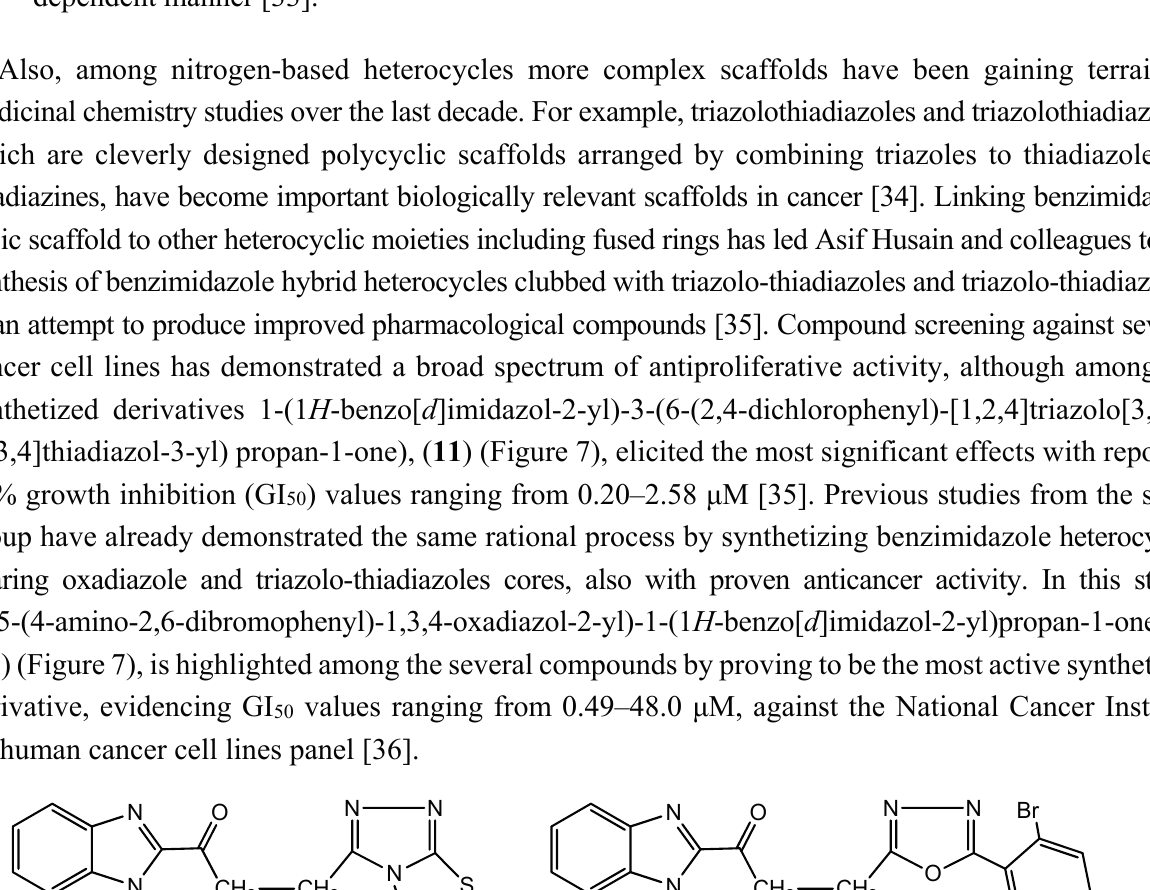
Figure 6. Chemical structure representation of N -(1-(2, 6-difluorob- benzyl)-piperidine-4- yl)-4-phenoxybenzamide complex with proven antiproliferative activity in HepG2 cells, through regulation of AMPK phosphorylation and by induction of cell cycle arrest p53/p21- dependent manner [33].